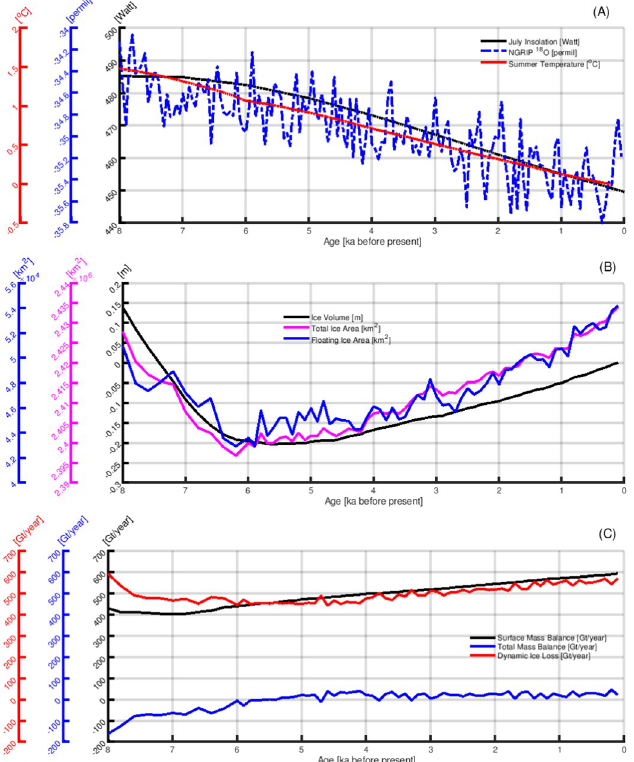
Fig 5. Evolution of Greenland Ice Sheet from the Holocene Thermal Maximum (i.e., 8 ka) to the Pre-Industrial era. A, top: Blue line: the oxygen δ 18 O isotope record from the NGRIP ice core [62]. Red line: the prescribed forcing of summer (JJA) temperature. Black line: July insolation at 70˚N [78]. B, center: Black line: ice volume of the GrIS. Pink line: total ice area of the GrIS. Blue line: floating ice area. C, bottom: Black line: surface mass balance of the GrIS. Blue line: total mass balance, positive indicate mass gain, and vice versa. Red line: rate of dynamic ice loss, i.e., discharge ice flux. As the sub-shelf ice flux and grounded basal mass flux are one order of magnitude smaller than that of the surface mass balance and the dynamic ice loss, the total mass balance of the GrIS is primarily controlled by the surface mass balance and dynamic ice loss. The above results are all based on the ensemble mean of the seven ensemble simulations.